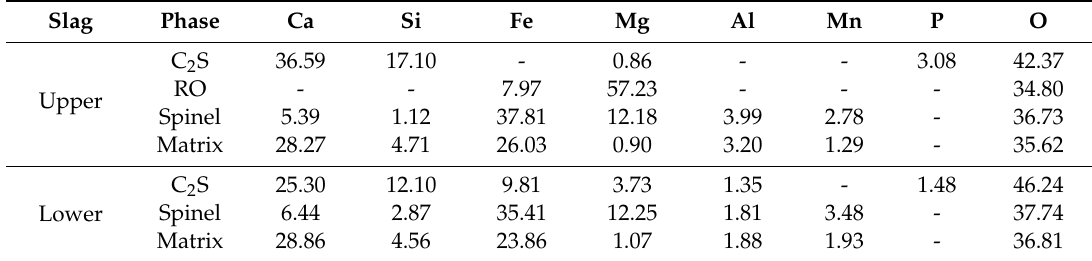
Figure 4. SEM images of the upper and lower modified slags held at 1673 K for 240 min after kilo-scale processing. Table 4. EDS analysis of the upper and lower modified slags held at 1673 K for 240 min processed at the kilo-scale (at%).